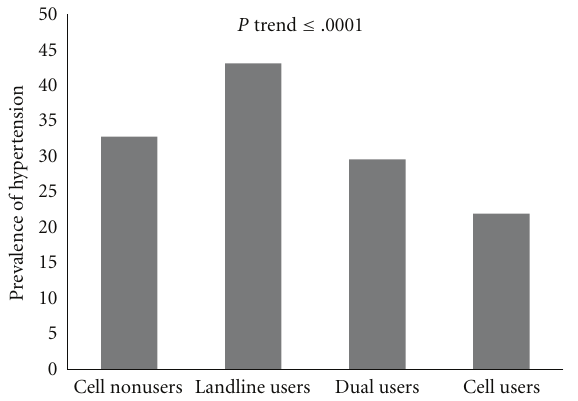
Figure 1: Prevalence of self-reported hypertension by cell-phone use